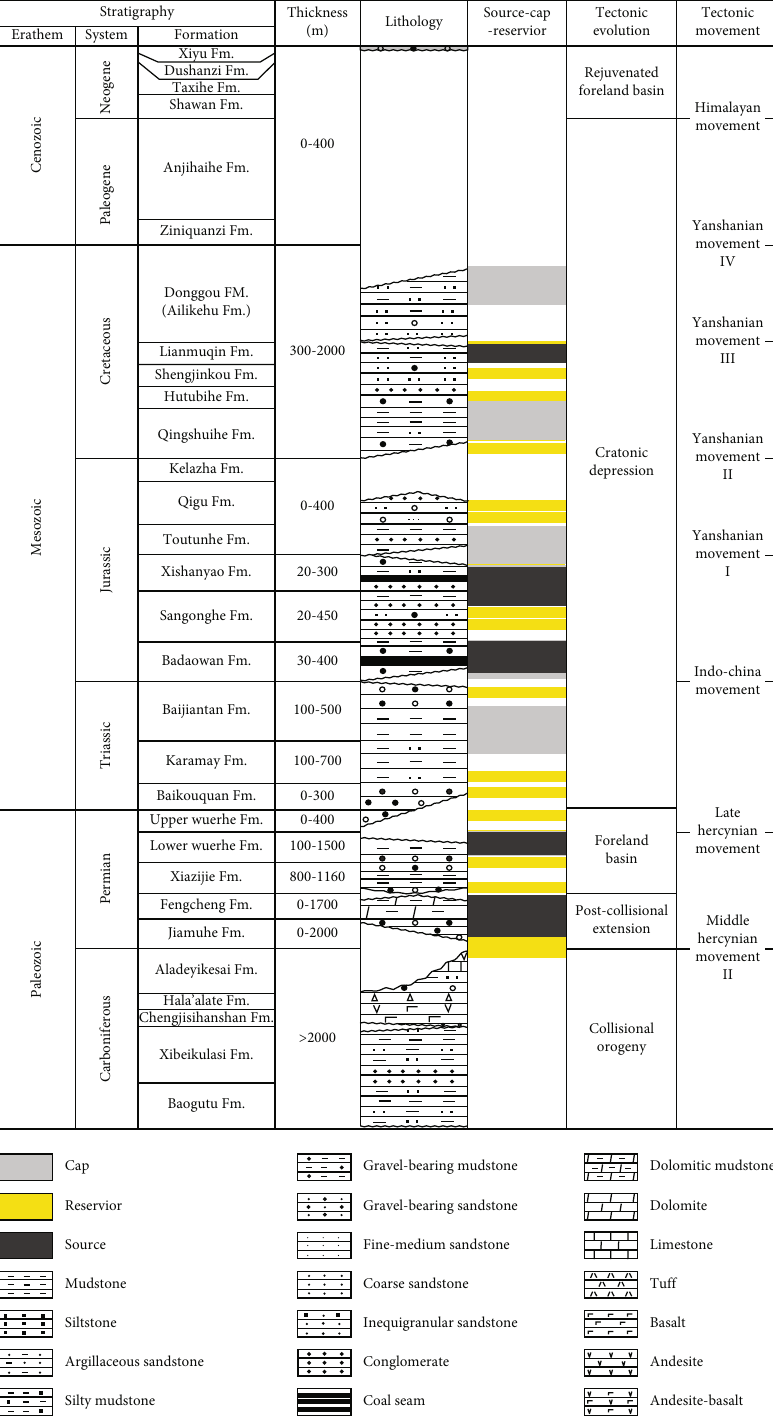
Figure 2: Tectonostratigraphic columns of the Mahu strata (T plotted on Figure 3 with di ff erent symbols. We can fi nd that b -P j ), the pressure coe ffi cients generally increase 1 1 pressure coe ffi cients of the Baijiantan-Karamay Formation with the increasing altitude of reservoirs (Figure 3). Di ff erent range from 0.8 to 2.1 with altitude from 1100-4000 m, and from the overlying formations, the pressure coe ffi cients of the pressure coe ffi cients exhibit a systematic increase with the upper Carboniferous have no obvious relationship with corresponding increase in altitude (Figure 3(b)). Besides, in the altitude (Figure 3(f)). We also constructed a cross- the Baikouquan Formation and its underlying Permian section of pressure coe ffi cient in the Mahu sag, from Well